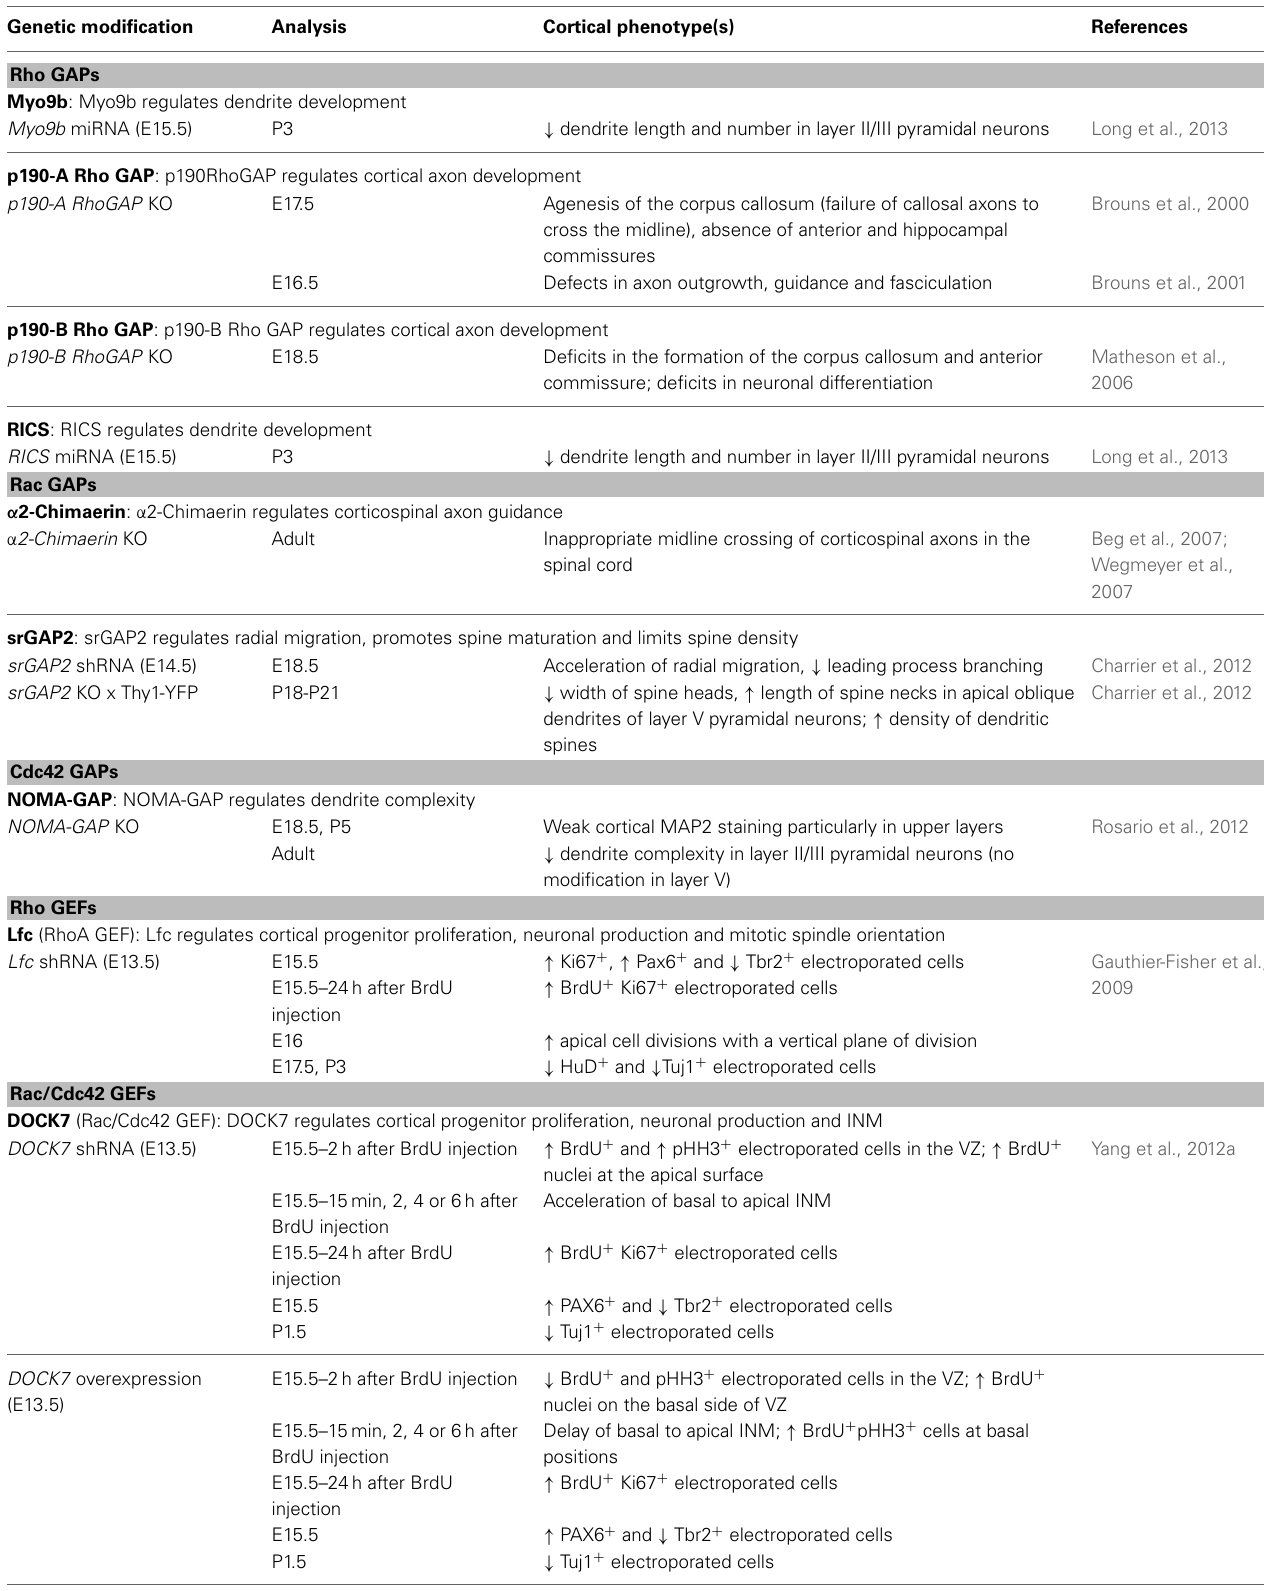
Table 2 | Regulation of cortical projection neuron development by GAPs and GEFs ( in vivo